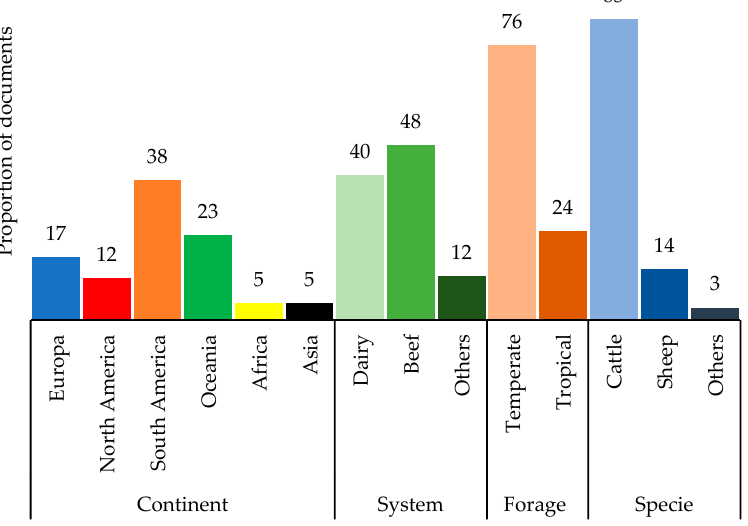
Figure 3. Distribution (%) of publications from the grazing category classified by continent, produc- tion system, forage type, and ruminant species.